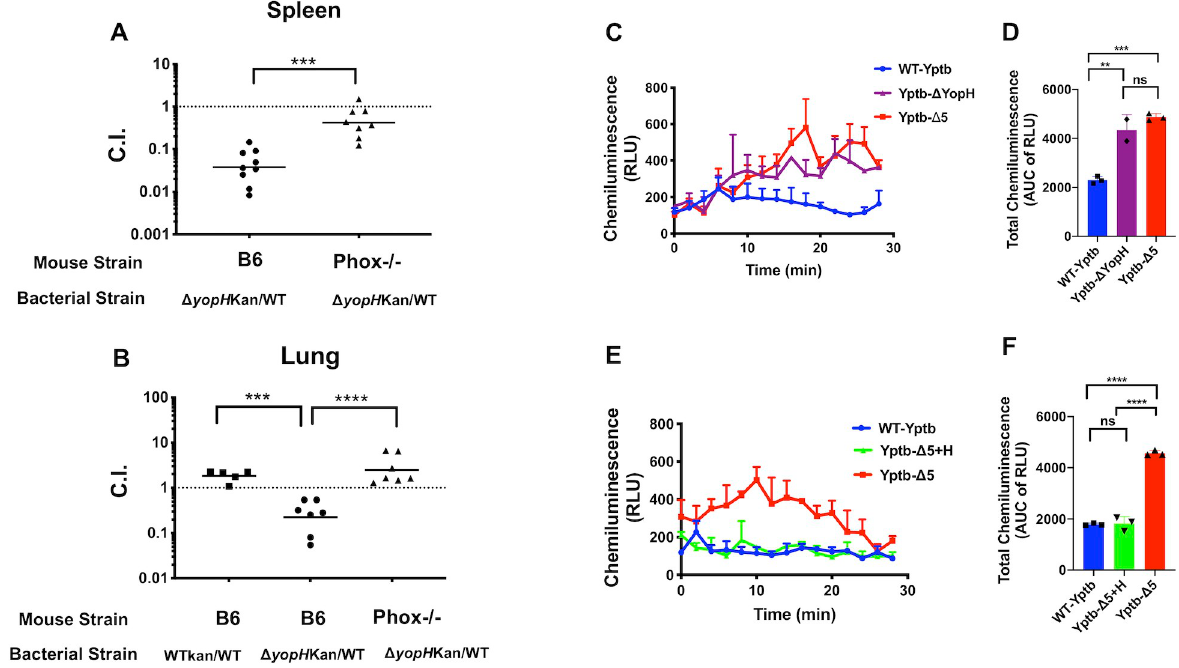
Fig 1. The growth of a Δ yopH mutant is restored in absence of ROS in vivo and YopH is necessary and sufficient to block extracellular ROS produced by BM neutrophils in vitro . (A-B) Female C57BL/6J or C57BL/6J gp91 phox-/- mice were inoculated with a 1:1 mixture of IP2666 WT- Yptb and Δ yopH -Kan R (A) intravenously with 1x10 3 CFU or (B) intratracheally with 5x10 3 CFU. Spleens and lungs were collected, weighed, homogenized, and plated for CFU two days post- infection. The competitive indices (C.I.) were determined by patching 100 colonies on L-Irgasan and L-Irgasan+Kanamycin plates. Each symbol represents an individual mouse; horizontal bars represent the geometric mean. (C-F) BM neutrophils were infected at a MOI of 20:1 with (C-D) WT- Yptb , Δ yopH , or Δ 5 (a mutant lacking 5 effector Yops, H, E, O, M, J), (E-F) WT- Yptb +pBAD, Δ 5+YopH (a strain expressing only YopH at native levels from an arabinose inducible plasmid),or Δ 5+pBAD, and monitored for extracellular ROS production using isoluminol chemiluminescence assay. (D and F) Total chemiluminescence was determined by computing the area under the curve (AUC) using GraphPad Prism version 7. Mean ± SD of a representative experiment from 2–3 independent experiments done in 2–3 replicates is presented. Statistical significance was calculated using (A) the Mann-Whitney t-test, (B) one-way ANOVA followed by Tukey’s Post-test after log 10 transformation of the data, or (D, F) one-way ANOVA followed by Tukey’s Post-test for area under the curve (AUC).